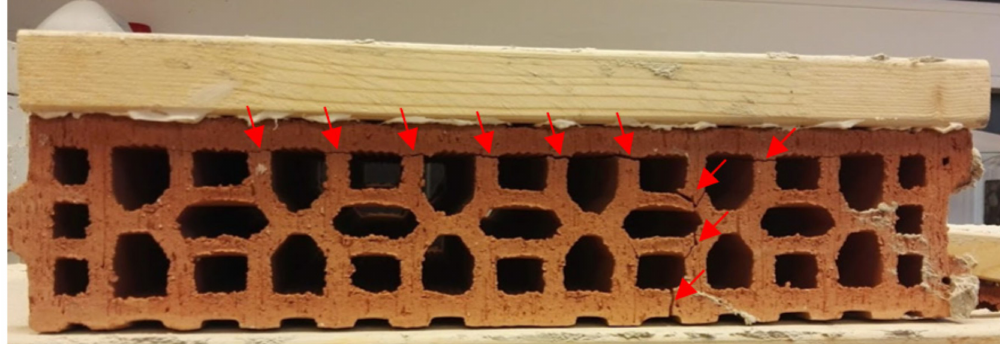
Figure 21. Damage of the brick substrate with C9 plaster